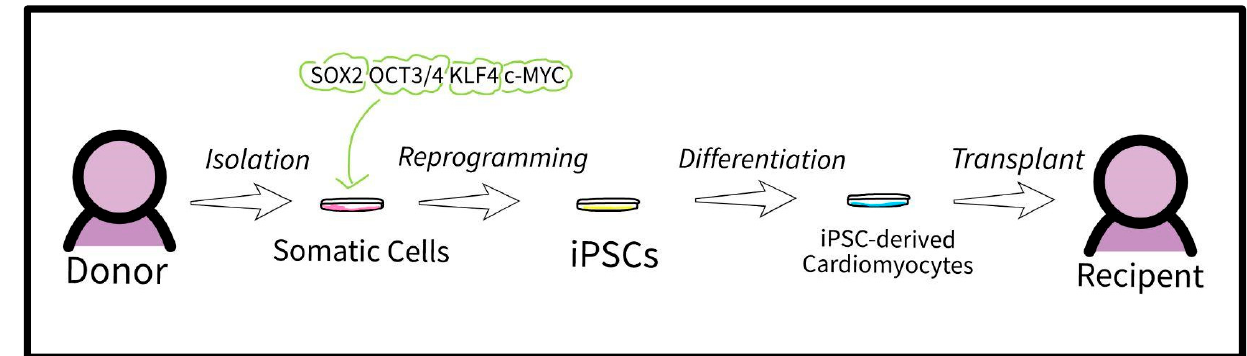
Figure 1. The process from isolation to transplantation for an iPSC-derived cardiomyocyte [15].